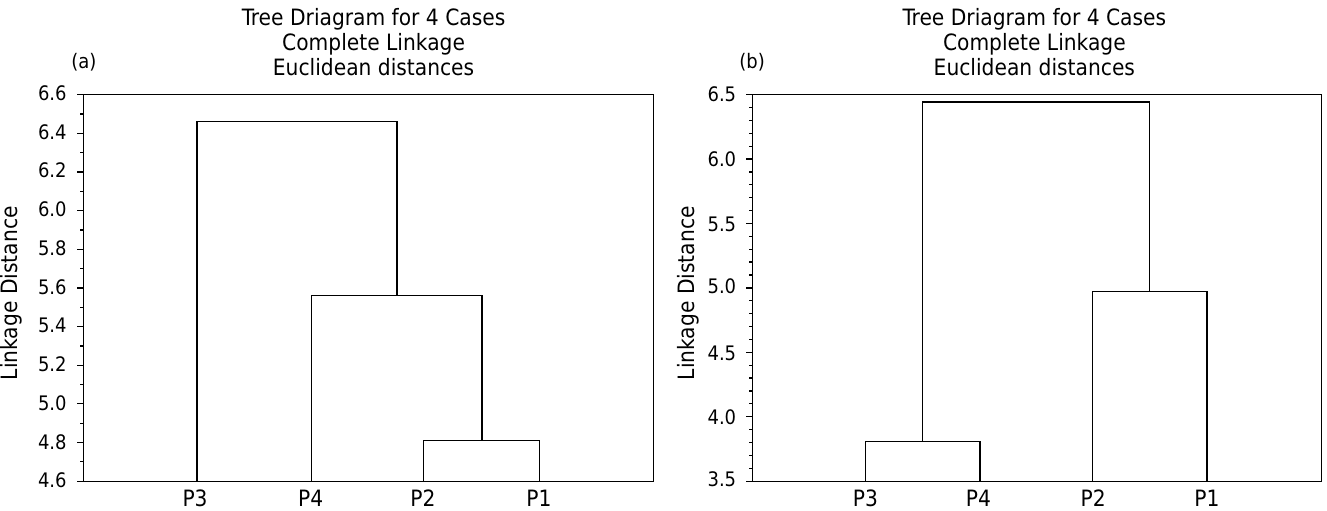
Figure 3. Dendrogram similarity based on physical attributes and saturated paste (a) and chemical (b) of the Bt horizon of soils (P1 – Profile 1; P2 – Profile 2; P3 – Profile 3; P4 – Profile